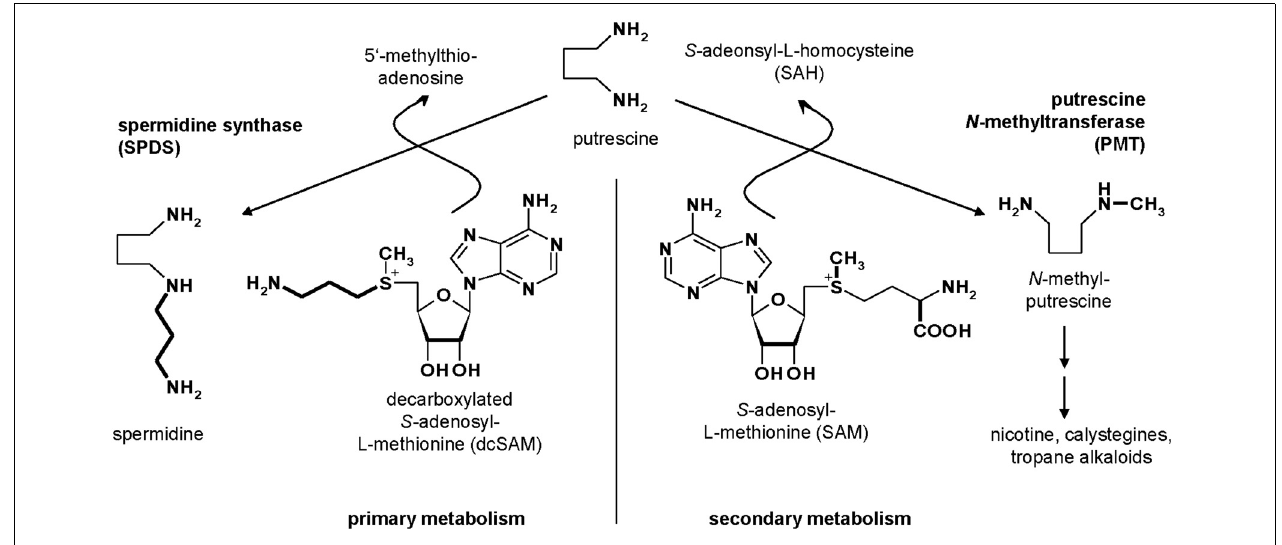
FIGURE 1 | Metabolism of